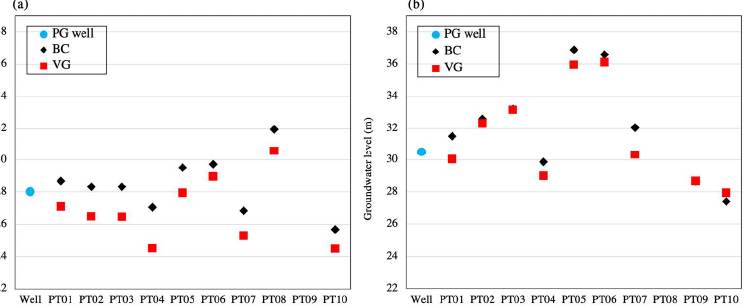
Figure 17. Estimated Groundwater Level comparisons of the Van Genchtan (VG) and Brooks–Corey (BC) for ( a ) dry season and ( b ) wet season. (BC) for ( a ) dry season and ( b ) wet